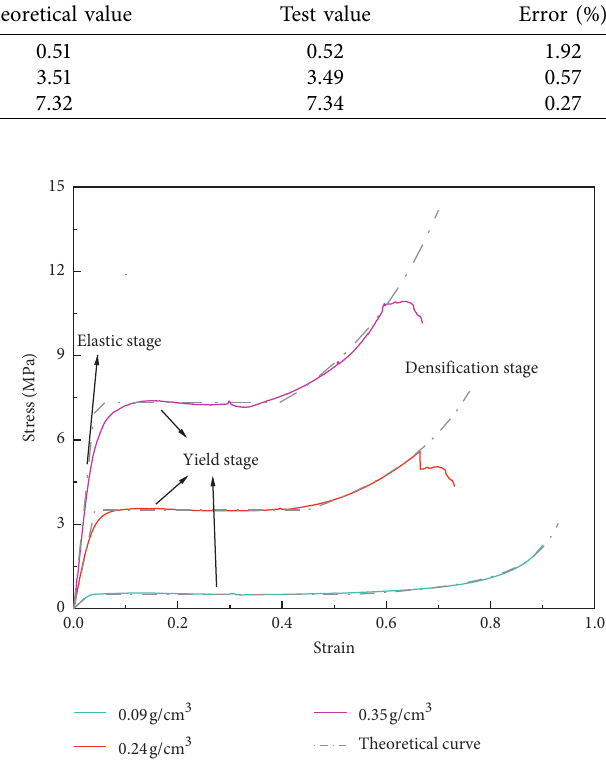
Figure 13: Theoretical and measured curve diagram of low-exo- therm modified polyurethane grouting